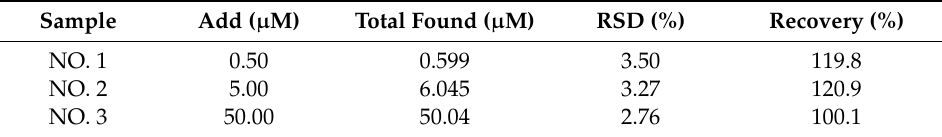
Table 2. OTC in the milk supernatant sample by CV ( n = 3).